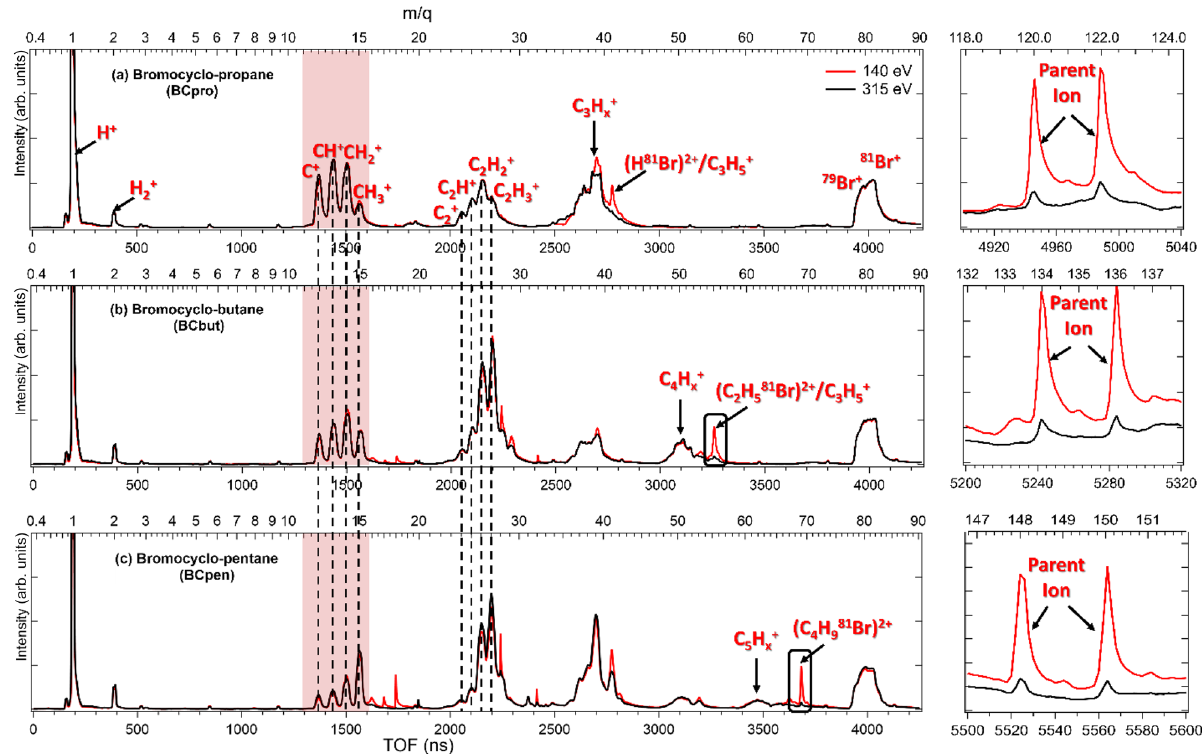
Figure 2. Mass spectra of ( a ) BCpro, ( b ) BCbut, and ( c ) BCpen irradiated at 140 eV (red) and 315 eV (black) photon energy, normalized to have the same integral counts. The mass spectra have no significant peak beyond 90 amu except for two small peaks corresponding to the parent ion, shown in the zoomed-in view on the